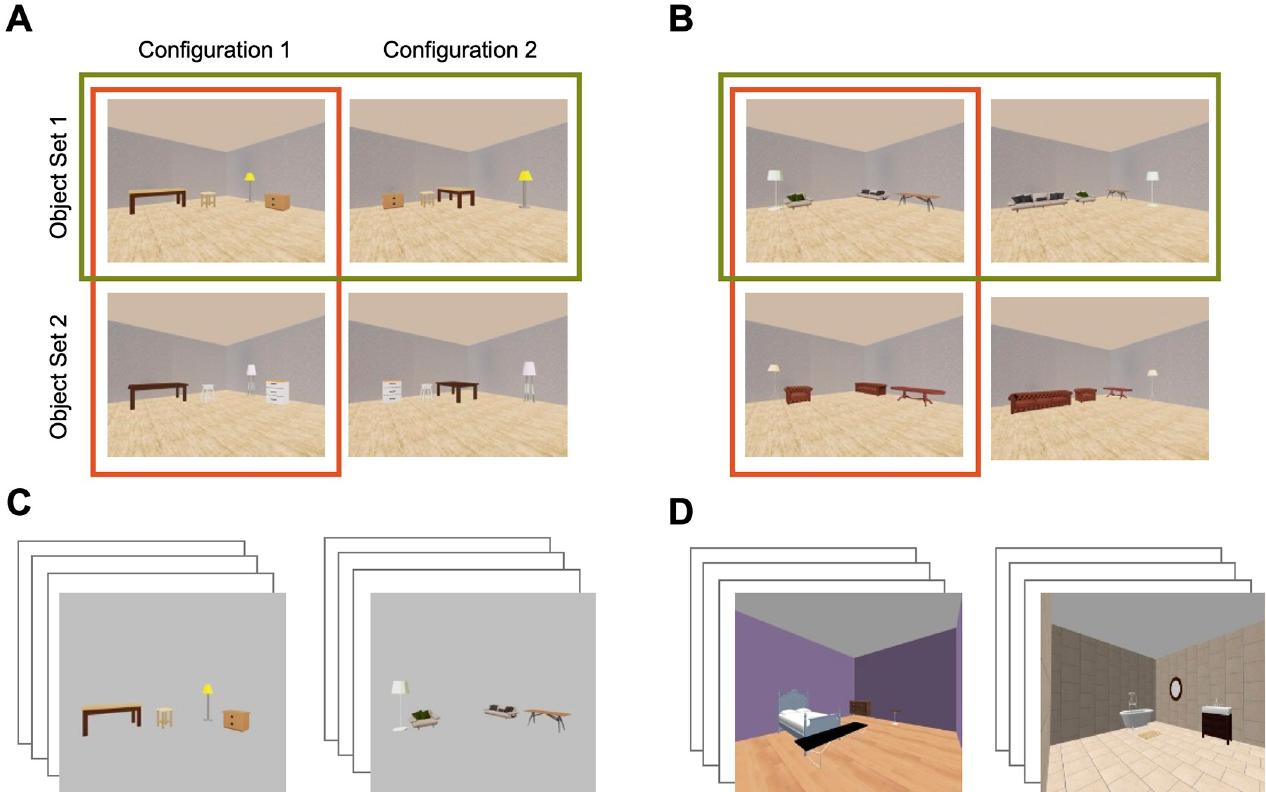
Fig 1. Image collections with different background manipulations. ( A ) and ( B ) Two example image sets from the “Fixed Background” image collection. All image sets in this collection had an identical room background. Each image set consisted of four unique images, constructed from two sets of objects and two configurations. Two images within a set could express the same configuration but with different objects (see the two images in the red box), or have the same objects but different configurations (see the two images in the green box). ( C ) Two example images from the “No Background” image collection. All image sets in this collection were shown without a room background. (D) Two example images from the “Variable Background” image collection. Each image set in this collection had a unique room background.